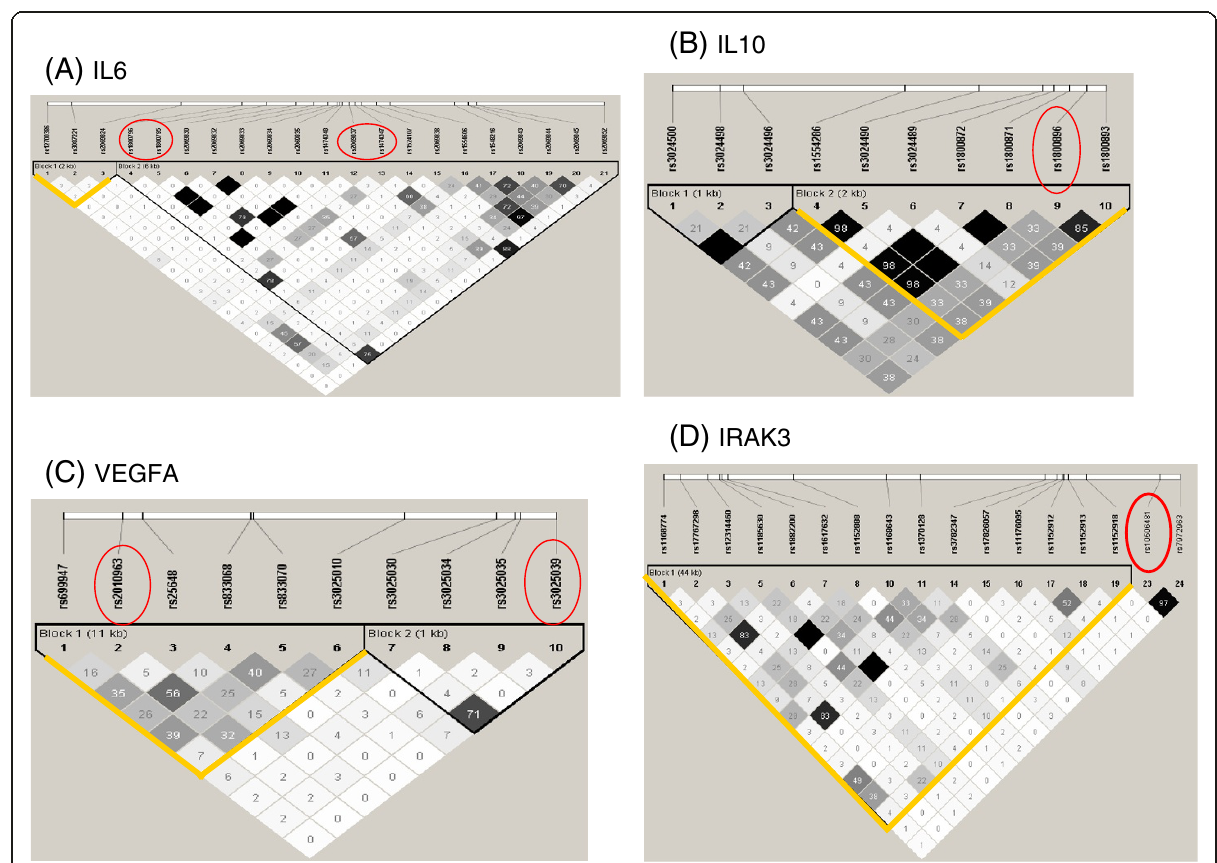
Figure 2 Linkage disequilibrium (LD) plots for African ancestry (AA) trauma subjects for 4 genes with positive ALI associations. Previously reported ALI-associated SNPs are circled in red, whereas the haplotype block detected to be ALI – associated by one or more kernel function is outlined in yellow. The grayscale reflects the pairwise LD as measured by r 2 , with high LD in black and low/absent LD in white. The ALI – associated genes are ( A ) IL6, ( B ) IL10, ( C ) VEGFA, and ( D )